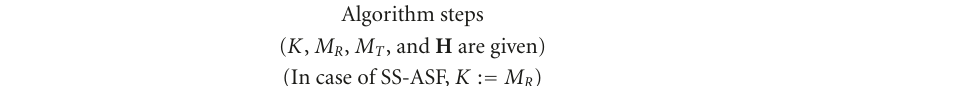
Table 1: Frobenius-norm-based algorithm for RASF. Algorithm